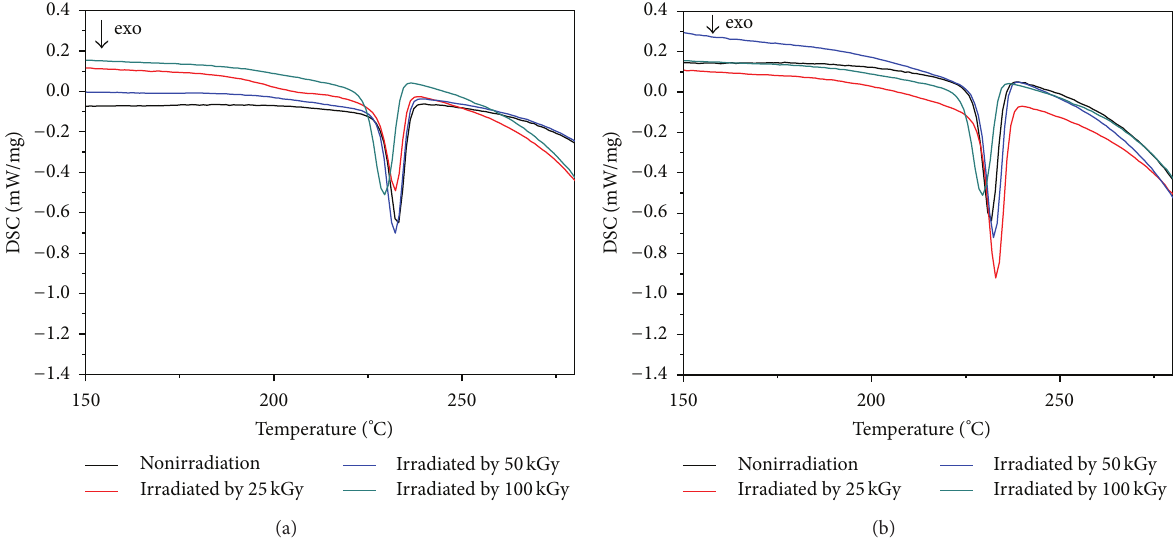
Figure 5: The curves for the crystallization behaviour of 40wt% (a) and 50 wt% (b) nHA/PA66 scaffolds irradiated by different